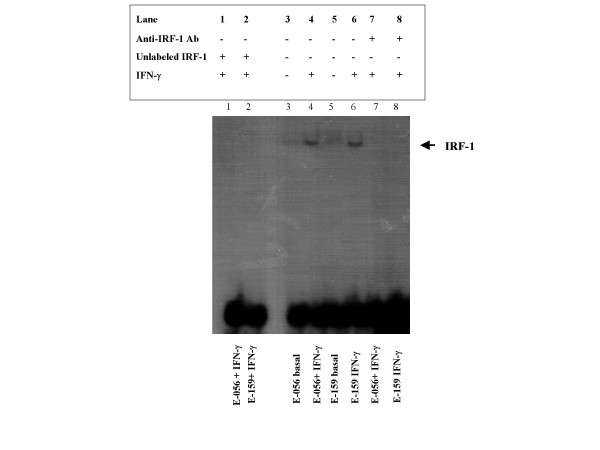
EMSA showing the binding of IRF-1 to a 32P labeled probe containing the IRF-1 consensus sequence. EMSA was performed with nuclear extracts obtained from untreated ESTDAB-056 (3) and ESTDAB-159 (5) melanoma cells or treated with 800 U/ml IFN-γ for 4 h (lanes 1, 4 and 7 corresponding to ESTDAB-056; and lanes 2, 6 and 8 corresponding to ESTDAB-159). A 50-fold molar excess of unlabeled IRF-1 probe was added to the binding reaction (lane 1, 2) to compete out the formation of a detectable complex. Anti-IRF-1 antibody was used to block IRF-1 binding to test the specificity of the interaction (lanes 7 and 8). Results shown are representative of at least three independent experiments.